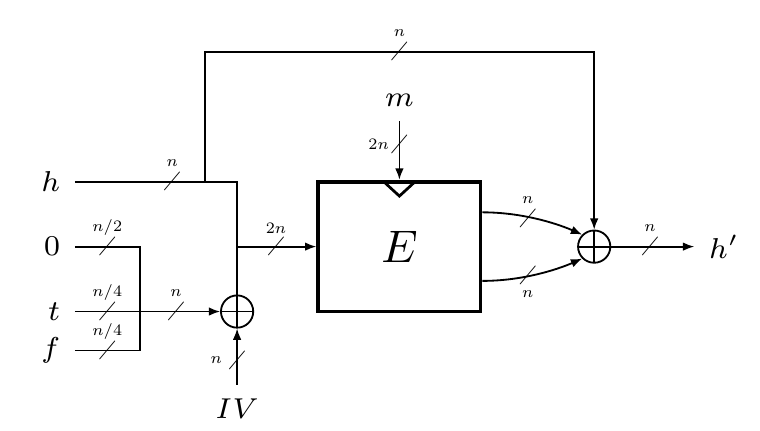
Figure 1: BLAKE2 compression